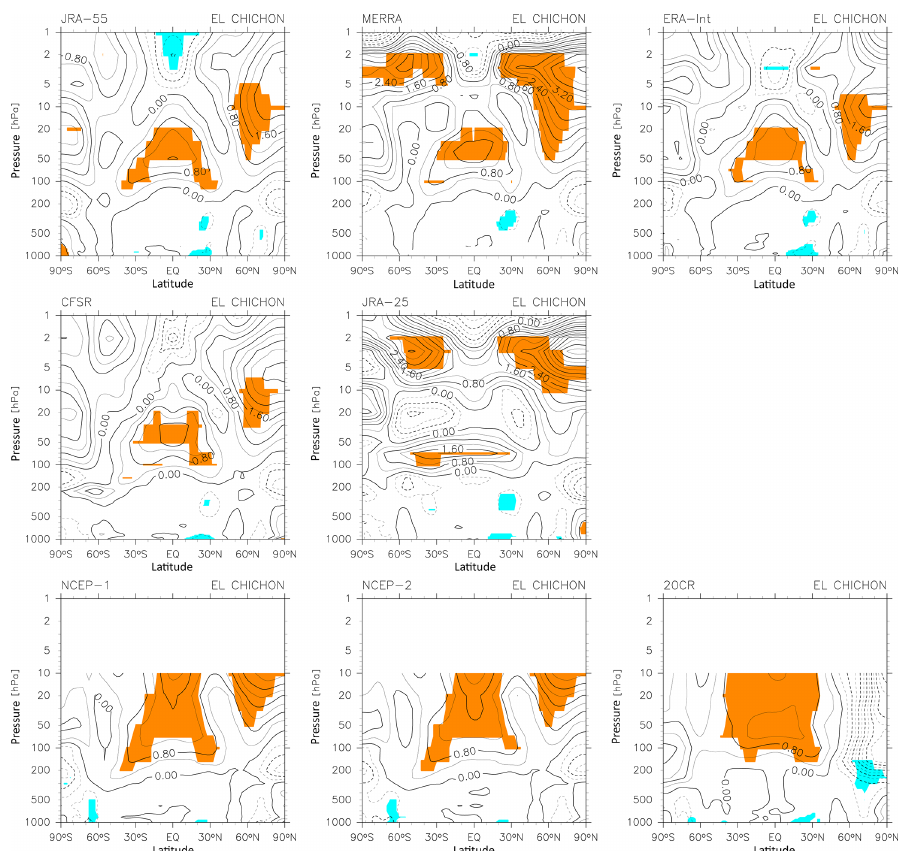
Figure 4. Latitude-pressure distribution of the temperature response to the El Chichón eruption in April 1982 for the 1979–2009 analysis from eight reanalysis data sets. Solid and dashed lines denote positive and negative values, respectively. The contour interval is 0.4K. Coloured regions denote those with positive and greater (orange) and negative and smaller (blue) than twice the SD of annual mean residual R(t) at each